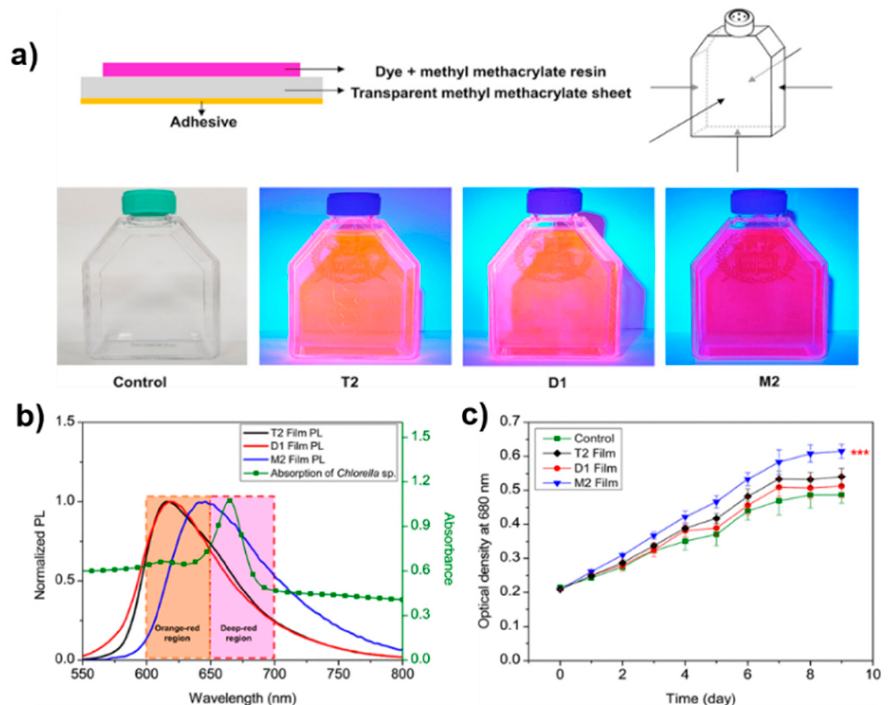
Figure 8. ( a ) Schematic of the culture flask covered with the LSC film and photographs of the device under 365 nm UV lamp irradiation (bottom). ( b ) Normalized emission spectra of the dye-coated LSC films (left axis and solid lines) and the absorbance of Chlorella sp. (light axis and dotted line). ( c ) Growth of Chlorella sp. monitored at an optical density (OD) of 680 nm. The OD 680 values of Chlorella sp. with different AIEgens dyes (T2, D1, and M2) are 11, 5, and 26% higher, respectively, compared to the control. (* p < 0.05; ** p < 0.01; *** p < 0.001). Reprinted with permission from Ref [94]. Copyright 2021 American Chemical Society.